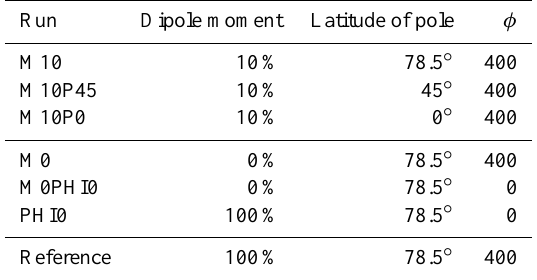
Table 1. Overview over the simulations that were carried out. The reference run has present-day solar and geomagnetic fields. Dipole moment in % of 8.25 × 10 22 Am 2 . φ in MV. Run Dipole moment Latitude of